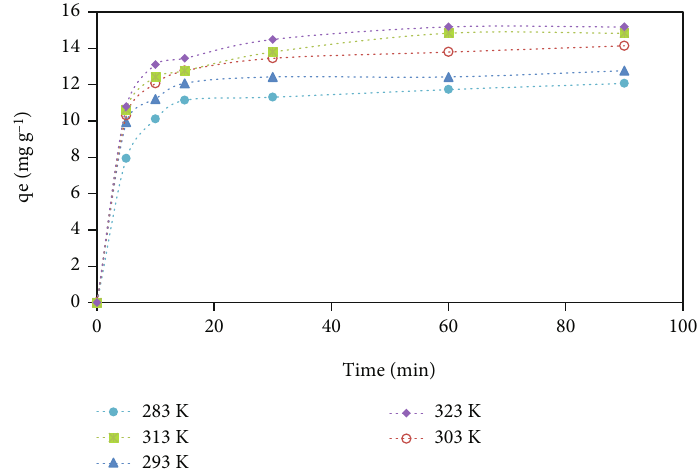
Figure 8: E ff ect of the initial temperature of the solution on the adsorption e ffi ciency of carmoisine on